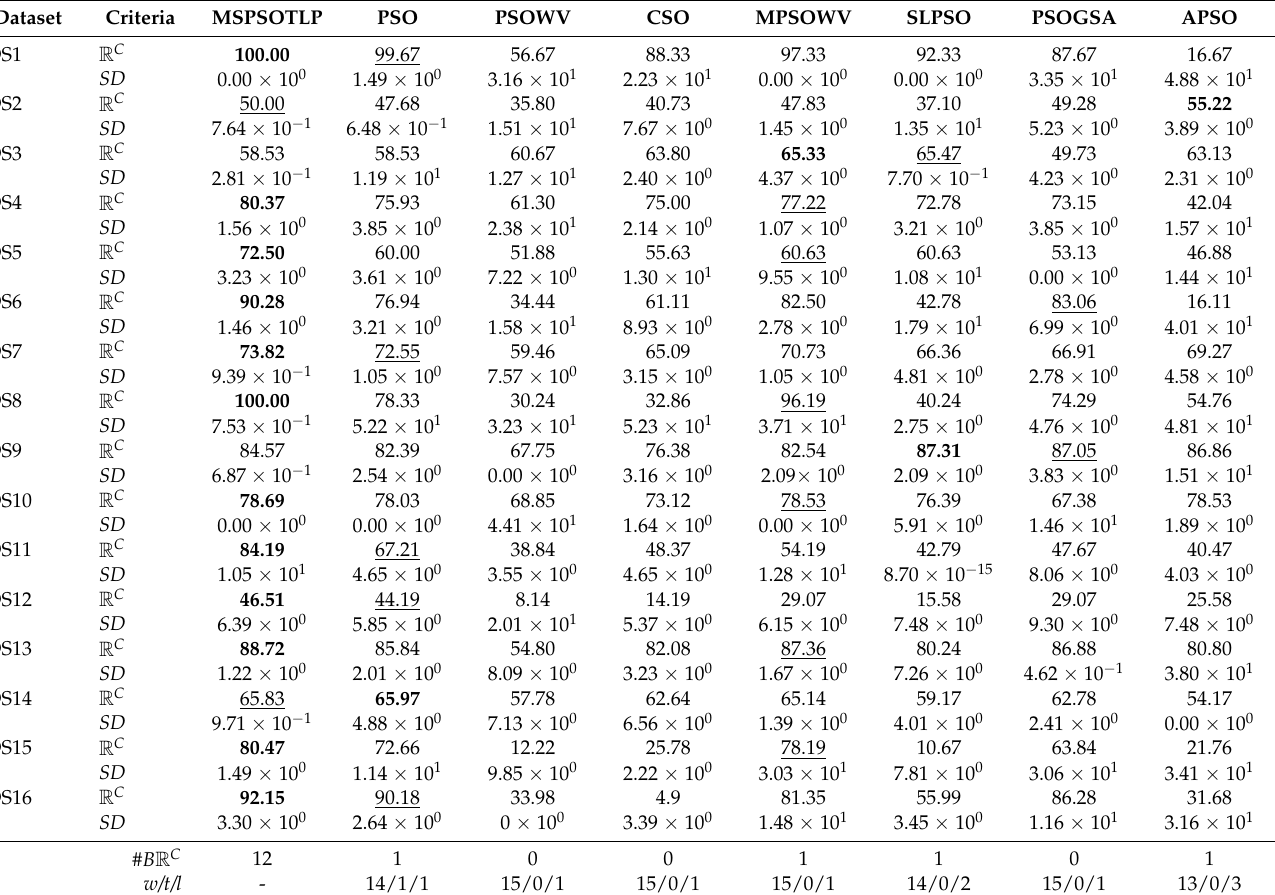
Table 12. The R C and SD values produced by ANN models trained by the proposed MSPSOTLP and other PSO variants when solving the testing